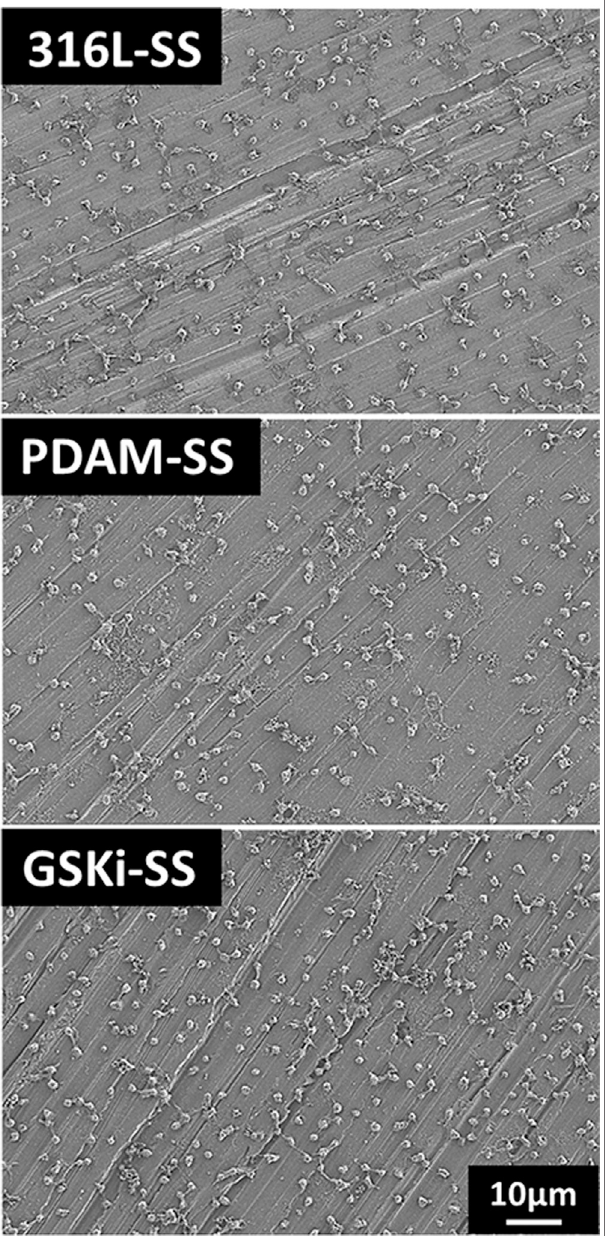
FIGURE 5 | Platelet adhesion on 316L-SS, PDAM-SS and GSKi-SS after contact with PRP for 2 h.